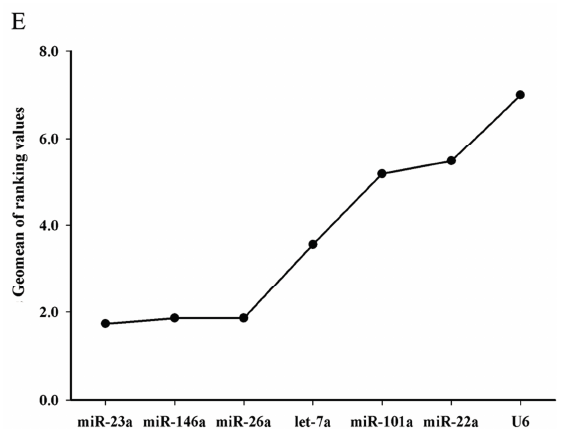
Figure 2. The recommended comprehensive ranking values calculated by RefFinder. ( A ) The stability was evaluated based on the entire data (all tissues, embryonic and post-embryonic developmental stages and fasting-refeeding experiment); ( B ) Different tissues. ( C ) Different embryonic developmental stages; ( D ) Different post-embryonic developmental stages; and ( E ) Fasting-refeeding treated. Table 2. Ranking of candidate reference miRNAs and U6 in consideration of all samples including tissues, developmental stages and fasting and refeeding experiment.